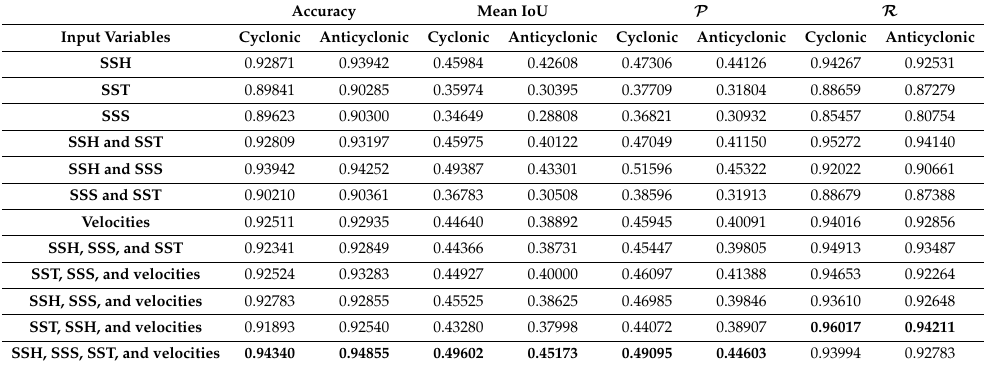
Table 1. Accuracy Metrics for different inputs to the neural network: The inputs to the U-Net– PSPnet model are varied systematically, and the corresponding accuracy metrics are evaluated and reported in the table. The table shows that the accuracy metrics are improved by approximately 5% when all five ocean-surface variables are used, as opposed to using only the SSH